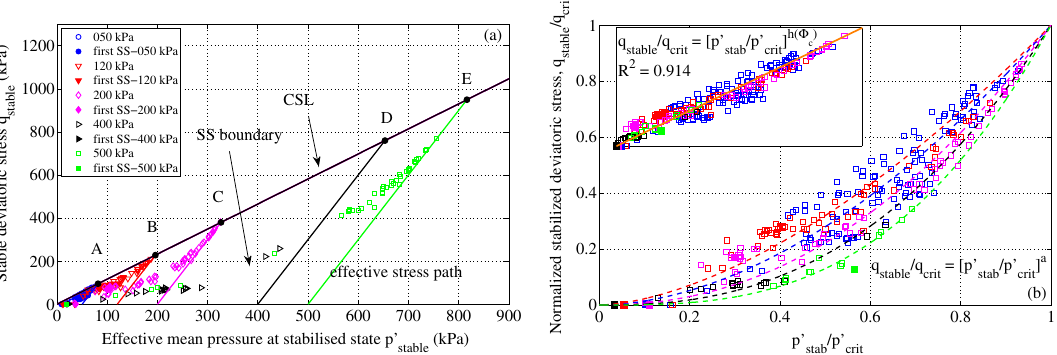
Figure 5. ( a ) Stabilized effective stress state of stick-slip motions in the effective stress ( p ′ − q ) plane for different constant confining stresses p ′ 0 , from 50 (A) up to 500 kPa (E). Inclined solid lines are the usual effective stress paths for drained compression tests from p ′ 0 to the failure point on the critical state line (CSL). Dotted points are the stabilized effective stress state calculated from the stabilized excess pore fluid pressure. ( b ) Normalized stick-slip boundary by failure point on the critical state line. The inset shows the unique stick-slip boundary with the linear scaling relation h (� c ) = a h ∗ � c + b h ( a h = 53.23, b h = -29.96, R